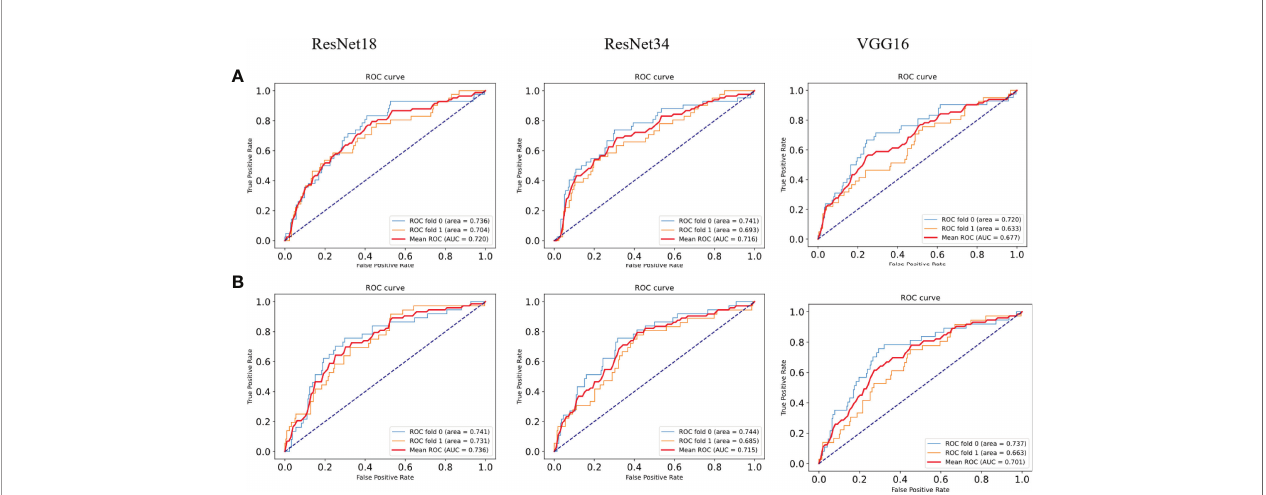
FIGURE 3 | ROC curves of the comparison models. (A) ROC plots for different models with a TMB cutoff of 10 under 2-fold cross-validation. (B) ROC plots for different models with a TMB cutoff of 20 under 2-fold